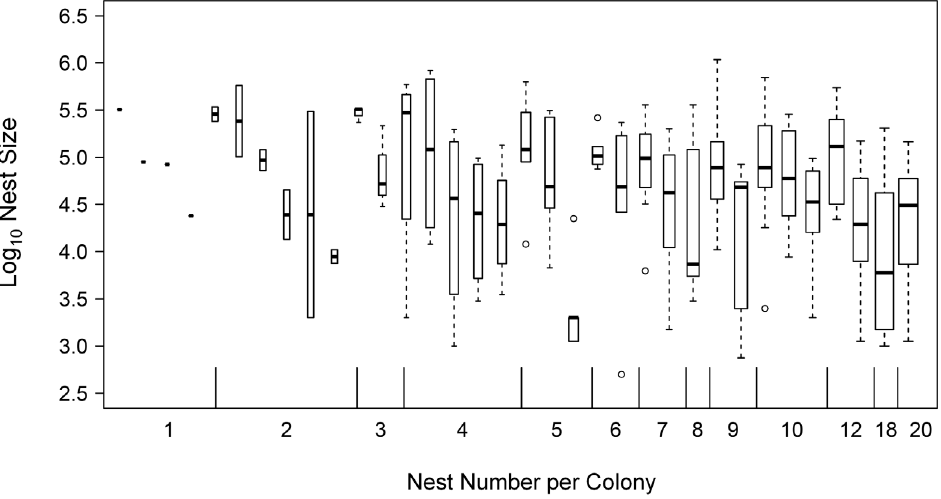
Fig. 6. The relationship between number of nests per colony and nest size. Nest size tends to decrease as number of nests per colony increases (Linear mixed effect model, fixed effect: t 5 –2.03, P 5 0.051, model AIC 5 462.33). Boxplot width is proportional to the square root of number of